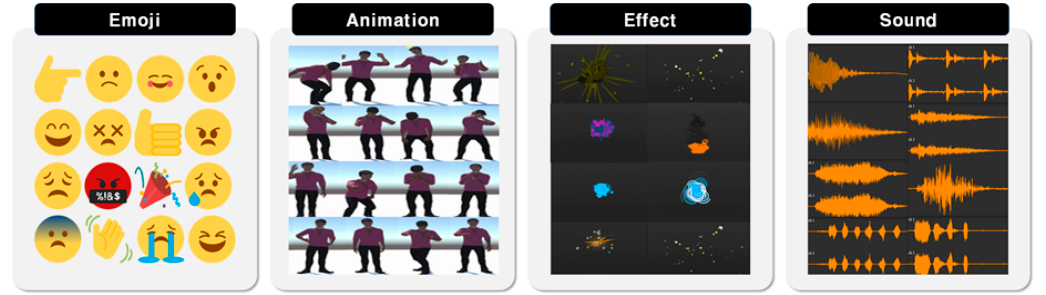
Figure 3. Four types of expression available in our messenger service.